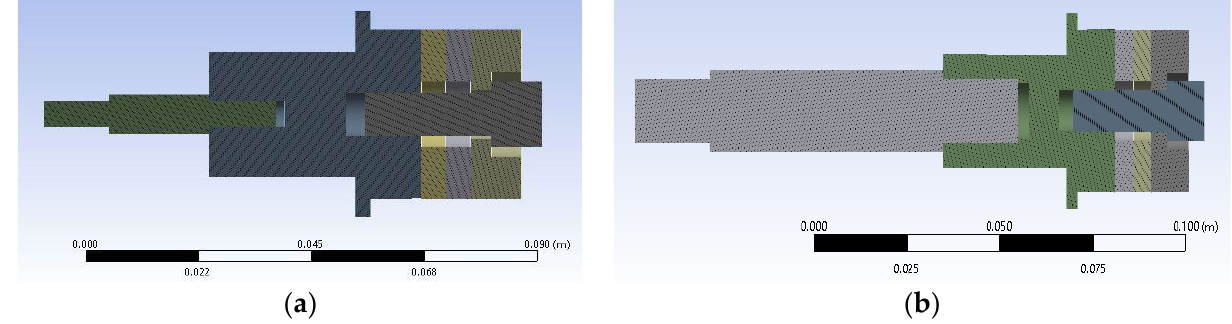
Figure 3. FE models for; ( a ) Transducer 1; and ( b ) Transducer 2.